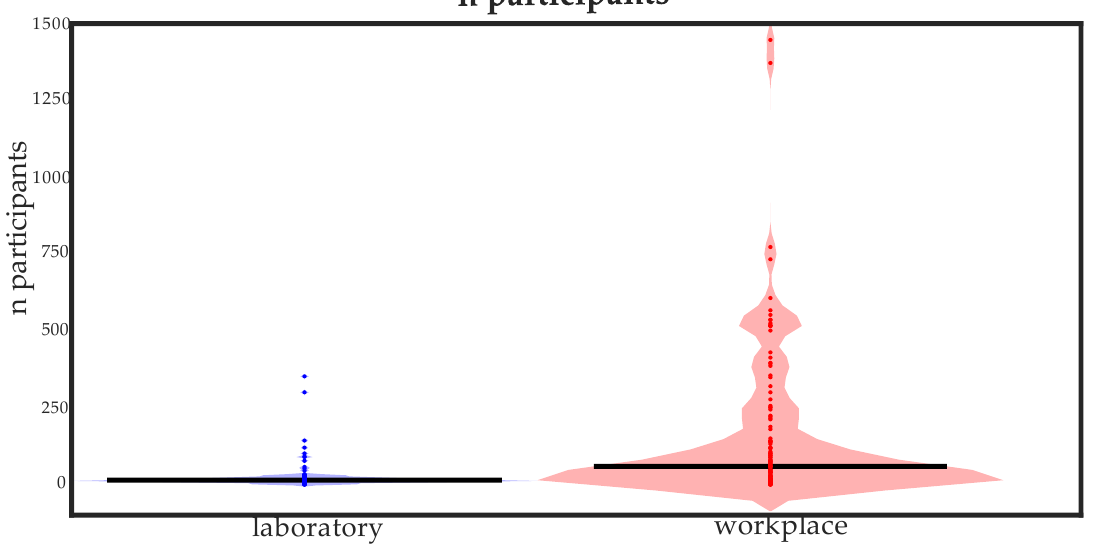
Figure 6. Distribution of the number of participants for a laboratory setting ( blue ) and for a workplace setting ( red ). The points indicate the value for each article and the black line is the median value. The number of participants (3141) of one workplace study is not shown in the figure for visualization purposes.